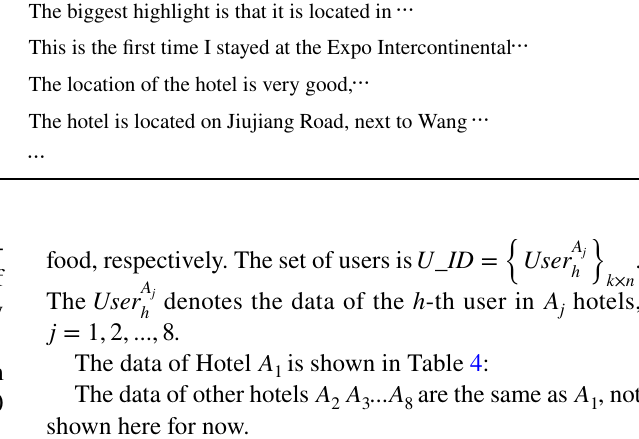
Table 3 Partial Evaluation Information in a hotel review on